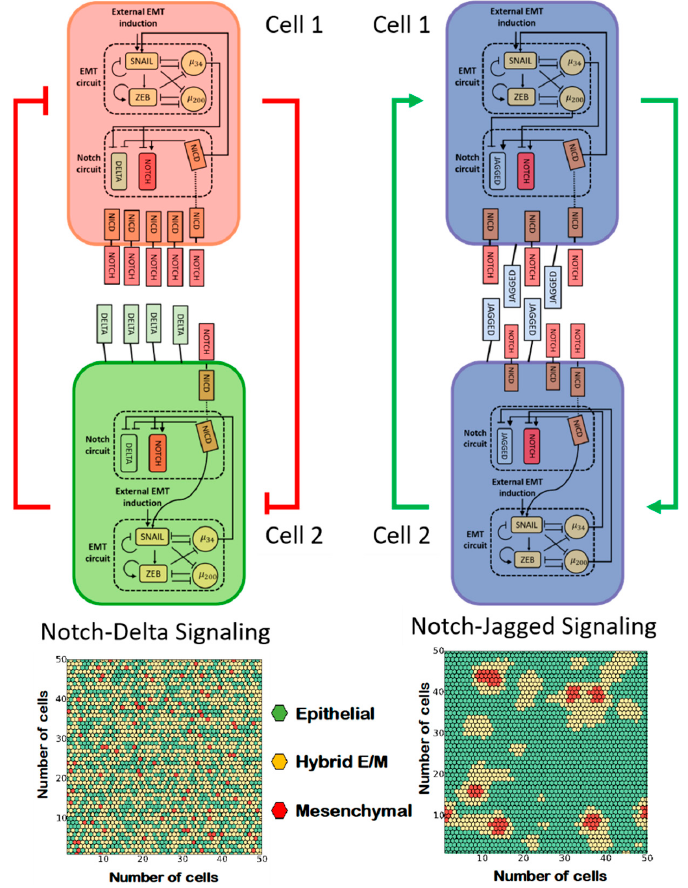
Figure 4. Notch–Delta and Notch–Jagged signaling give rise to opposite cell patterning of